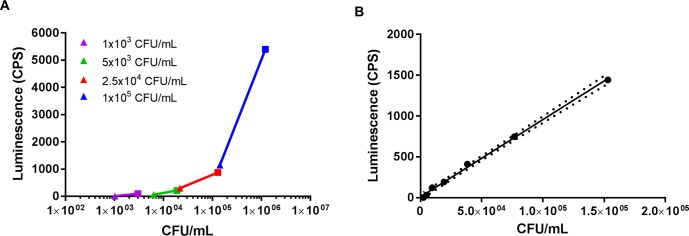
Optimization of bacterial cell concentration for L-SBA.(A) Different bacterial concentrations were tested with 5% BRS and measured by luminescence at T0 (triangle symbol) and at T180 (square symbol). (B) Bacterial cells at 1.5 x 105 CFU/mL were diluted down until 1.0 x 103 CFU/mL and measured by luminescence. The area within the dashed lines define the confidence interval of the best-fit line of the linear regression (y = 0.009465x + 10.28). CPS, counts per second.